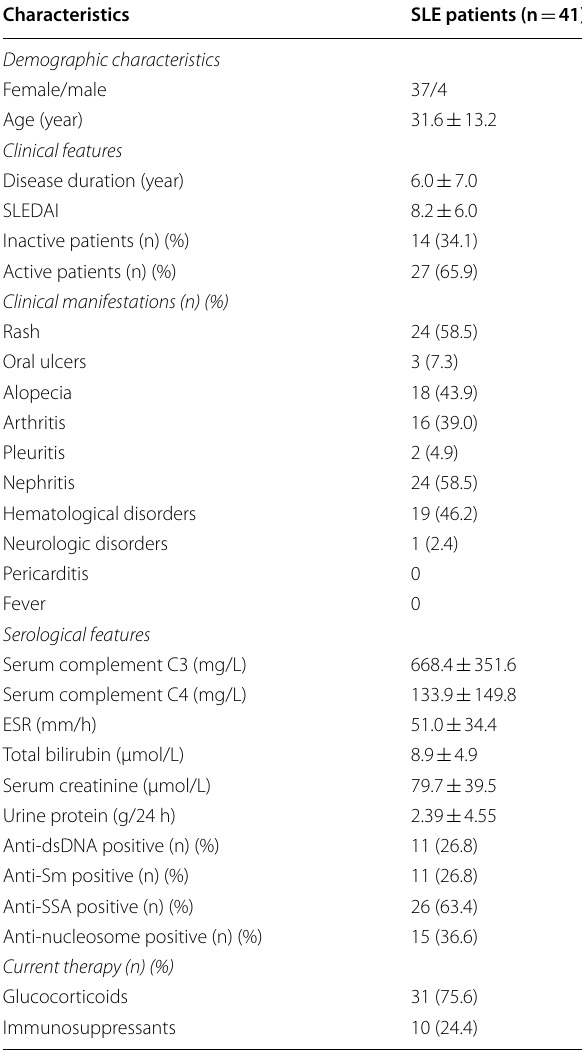
Table 1 Demographic and clinical characteristics of SLE